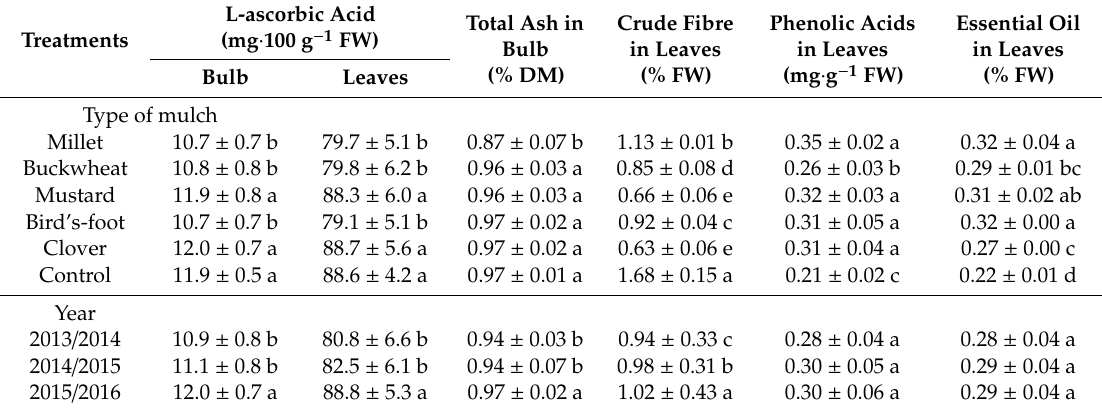
Table 7. E ff ect of mulch type and year of cultivation on chemical composition of winter garlic edible